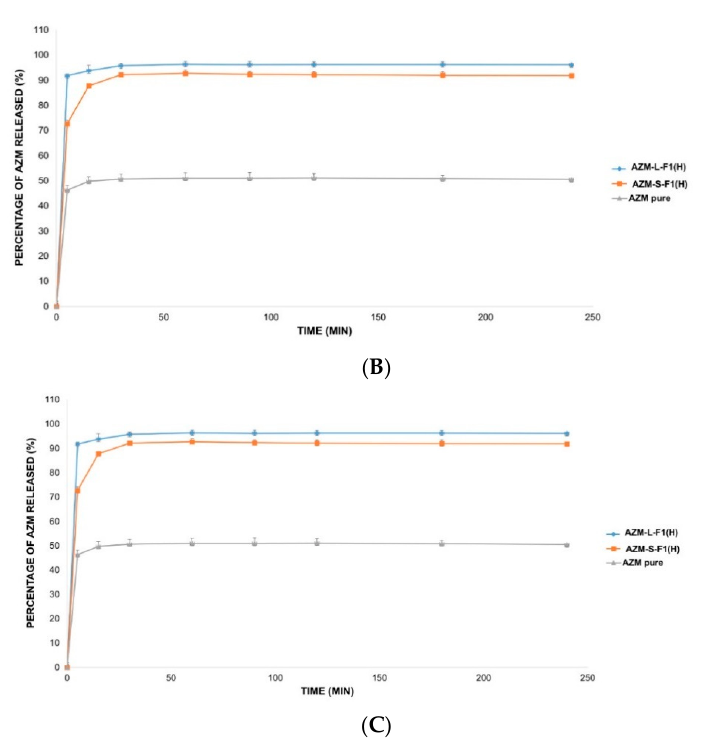
Figure 7. The in vitro release profile of AZM-L-F1 (H) , AZM-S-F1 (H) formulations, and pure AZM in DW, HCl, and SIF, respectively. ( A ) The in vitro release profile in DW. ( B ) The in vitro release profile in 0.1 mM HCl (pH = 4). ( C ) The in vitro release profile in SIF pH = (6.8).